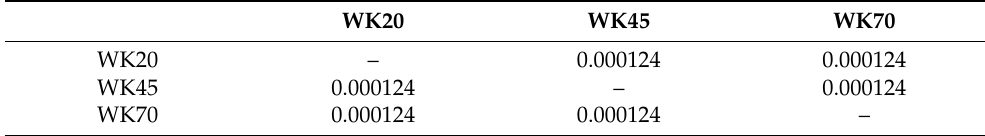
Table 5. Results of Tukey’s post hoc test for the WK group of dies.